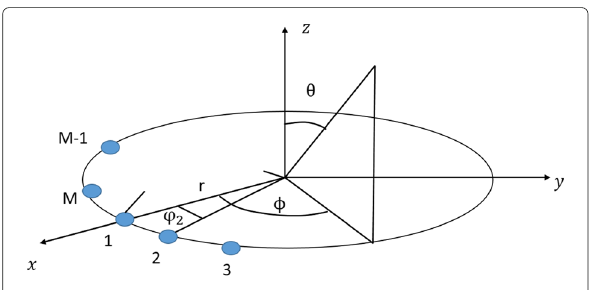
Fig. 3 A uniform circular array with signal direction angle ( θ , φ